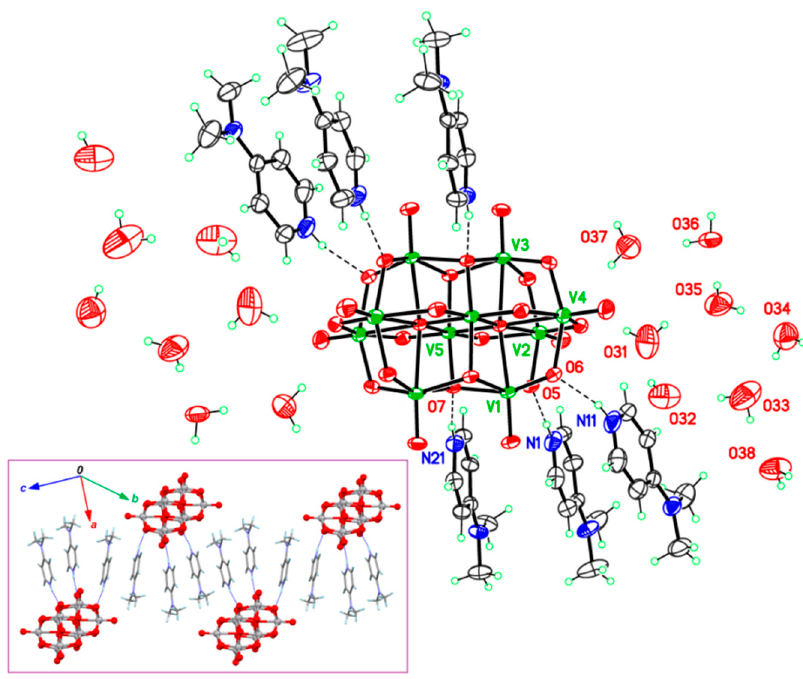
Figure 2. The unit cell contents of compound 2 , (DMAPH) 6 [V 10 O 28 ]·16H 2 O. Displacement ellipsoids were drawn at the 50% probability level. Main atoms were labeled in the asymmetric unit, and the complete cell is generated by symmetry code 2 − x , 2 − y , 2 − z . The dashed lines represent H bonds between cations and anions. The inset represents a part of the crystal structure, omitting all lattice water molecules [27]. The orientation for this projection evidences the stacking of cations in the crystal.